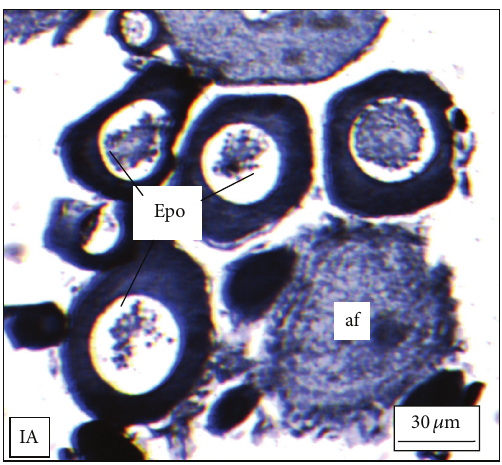
Figure 12: The histological section of the ovary of a M. tengara during the late spawning phase (August) showing large number of earlyperinucleolaroocytes(Epo)andfewprevitellineatreticfollicles (af) when the tissues are treated with ZnS nanoparticles at the concentration of 500 𝜇 g/L [IA: Iron-Alum